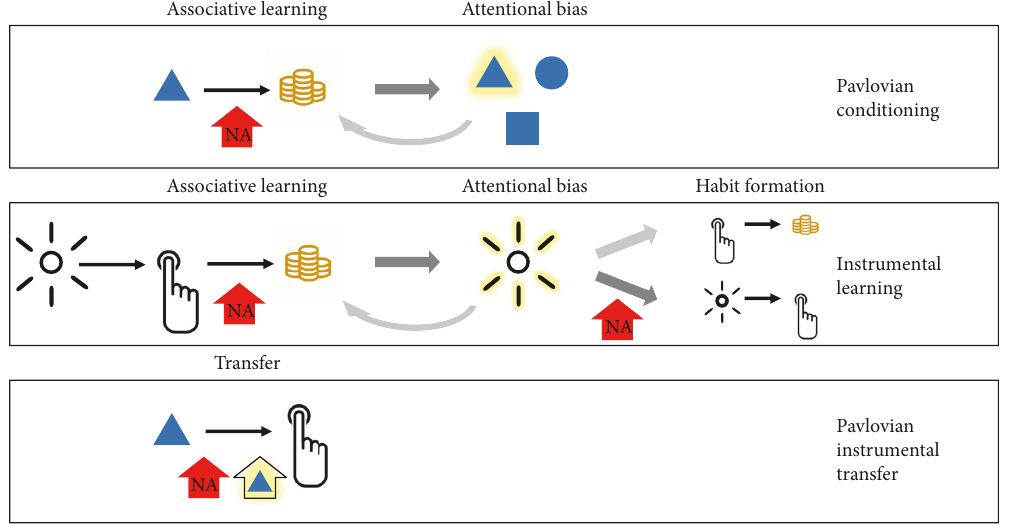
Figure 2: Overview over how (appetitive) noradrenaline (NA) modulated associative learning may give rise to attentional biases. In a simple Pavlovian conditioning paradigm, NA may in fl uence associative learning processes leading to attentional bias for conditioned stimuli (CS) (for both appetitive and aversive unconditioned stimuli). In instrumental learning, initial learning of action-outcome relation is a ff ected by NA giving rise to attentional biases for action-triggering stimuli. In a second step, attentional biases and noradrenergic processes may bias behaviour towards the habitual by strengthening stimulus-response over action-outcome relations. Finally, Pavlovian CS can in fl uence instrumental responding, a process that may be in fl uenced by both NA and attentional biases to the CS. Enhanced associative learning can manifest in excessive attentional biases characteristic of